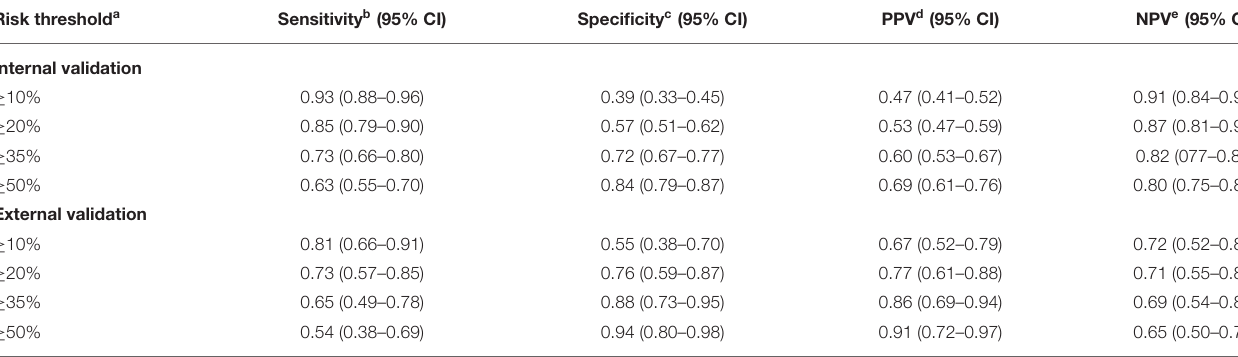
TABLE 3 | Internal and external validation classification performance at different risk